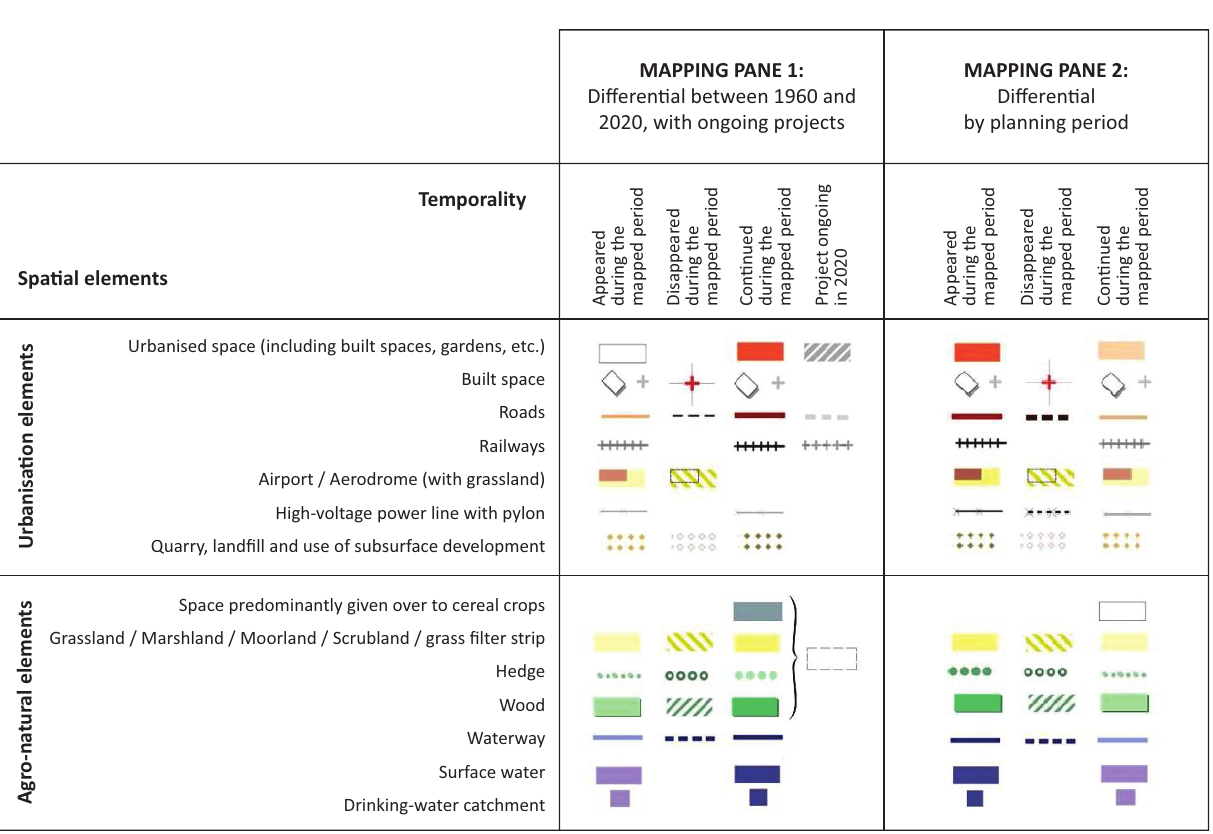
Figure 5. Legend for the mapping of the palimpsest of milieus . Source: